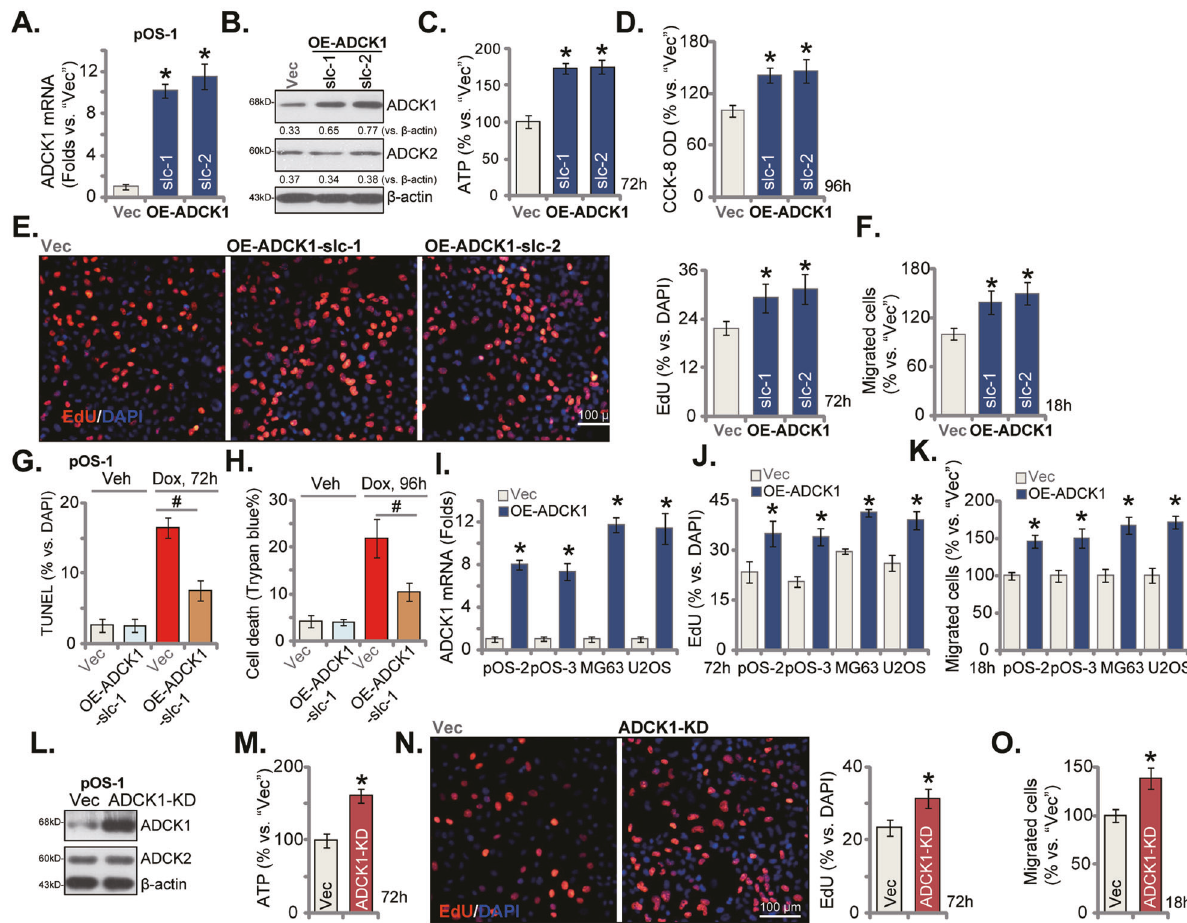
Fig. 6 ADCK1 overexpression promotes OS cell proliferation and migration. The primary human OS cells (pOS-1, pOS-2 and pOS-3) as well as the established lines (MG63 and U2OS), bearing the ADCK1-expressing construct ( “ OE-ADCK1 ” , “ slc-1/2 ” stands for two stable selections for pOS-1 cells) or the empty vector ( “ Vec ” ) were established, ADCK1 and ADCK2 expression was tested by qRT-PCR and Western blotting assays ( A , B , I ); Cells were further cultured for applied time periods, ATP contents ( C ), cell viability (CCK-8 OD, D ), proliferation (by examining nuclear EdU staining, E , J ) and migration ( “ Transwell ” assays, F , K ) were tested by the listed assays. OE-ADCK1-slc-1 pOS-1 cells or the Vec control cells were treated with doxorubicin (Dox, 2 μ g/mL) or vehicle control ( “ Veh ” ) for the designated hours, cell apoptosis and death were tested by the nuclear TUNEL staining ( G ) and Trypan blue staining assays, respectively, and results were quanti fi ed ( H ). Stable pOS-1 cells, with the kinase dead mutant ADCK1 ( “ ADCK1-KD ” , containing K183I, D315A, and D338N triple mutations) or the empty vector ( “ Vec ” ), were established, and expression of the listed protein was shown ( L ); Cells were further cultured for applied time periods, ATP contents ( M ), cell proliferation (by examining nuclear EdU staining, N ), migrated cell number ( “ Transwell ” assays, O ) were tested similarly. Data were presented as mean ± standard deviation (SD, n = 5). * P < 0.05 vs. “ Vec ” cells. # P < 0.05. The experiments were repeated fi ve times with similar results obtained. Scale bar = 100 μ m ( E , N